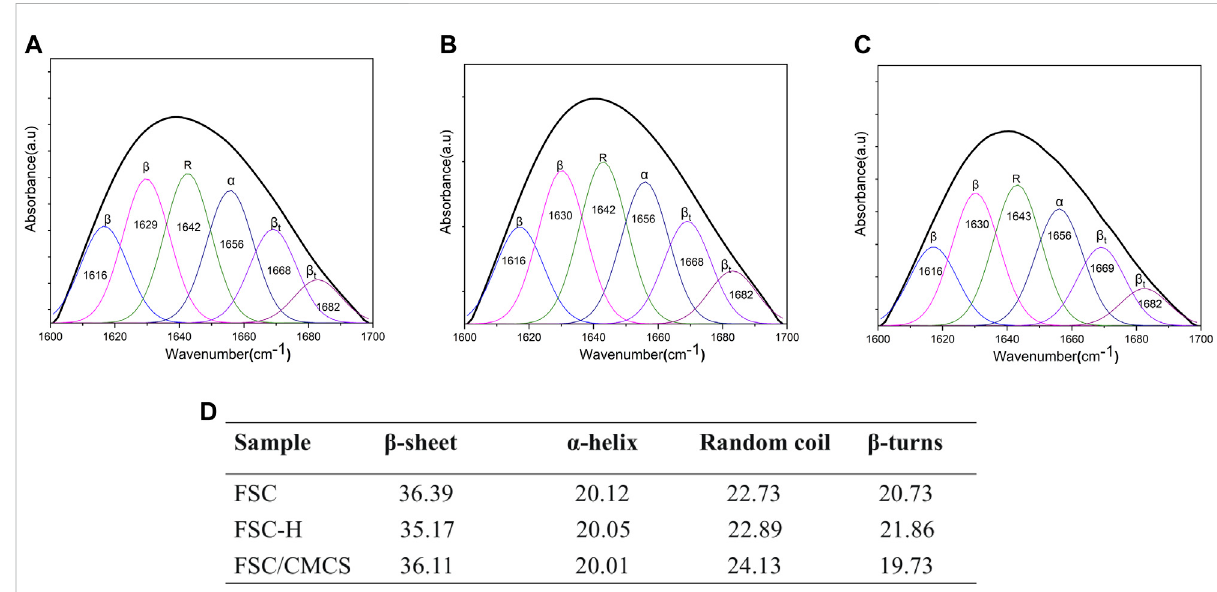
FIGURE 4 Quantitative analysis of the amide I bands in the samples. (A) FSC. (B) FSC-H. (C) FSC/CMCS. (D) Contents of secondary structures in the silk protein